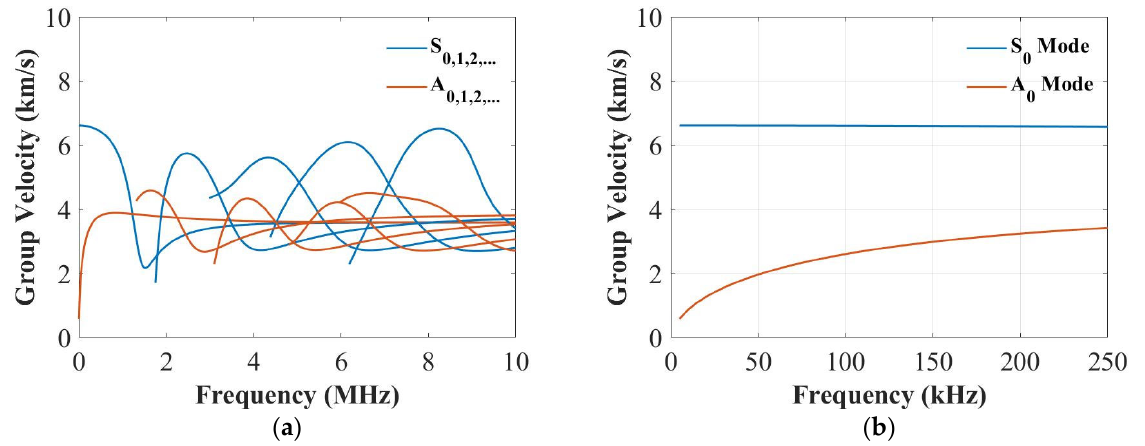
Figure 2. Dispersion curves for the group velocity from 0 to 10 MHz ( a ) and from 0 to 250 kHz ( b ) for the 2 mm thick panel.